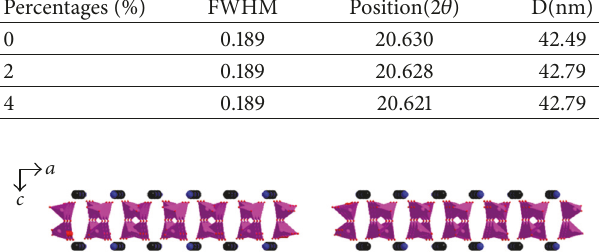
polyphosphates [30, 31] proves that positions of infrared absorption bands are characteristic of phosphates with chain